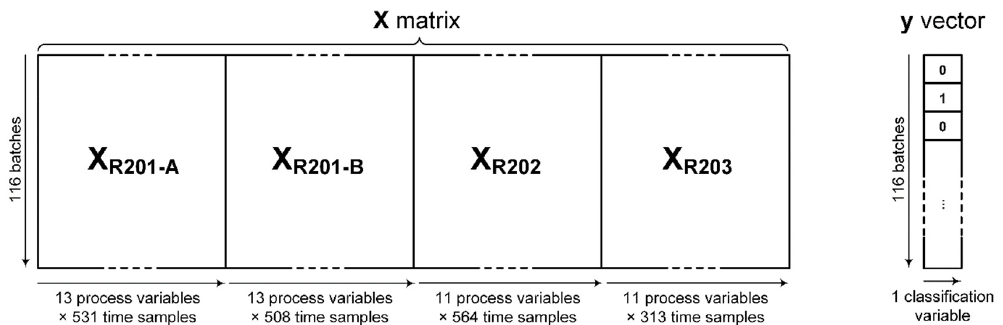
Figure 9. Representation of the matrices used to build the PLS-DA multiblock model. The overall 𝐗 matrix is obtained from the 𝐗 matrices of R201 (Step A and Step B), R202, and R203; the 𝐲 vector is the same classification vector used in the individual-unit analysis.